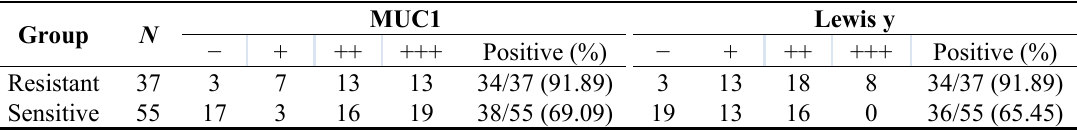
Table 1. The expression of Mucin-1 (MUC1) and the Lewis y antigen in chemoresistant and chemosensitive